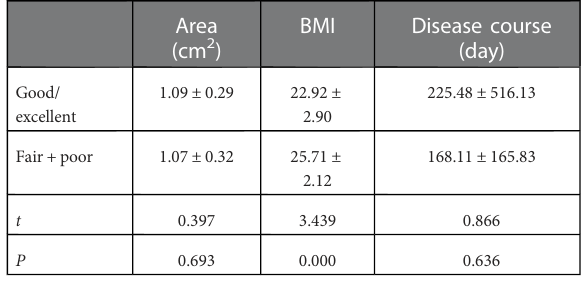
TABLE 4 Comparison of cartilage lesion area, BMI, and disease course between patients with good/excellent joint function and those with fair and poor joint function.